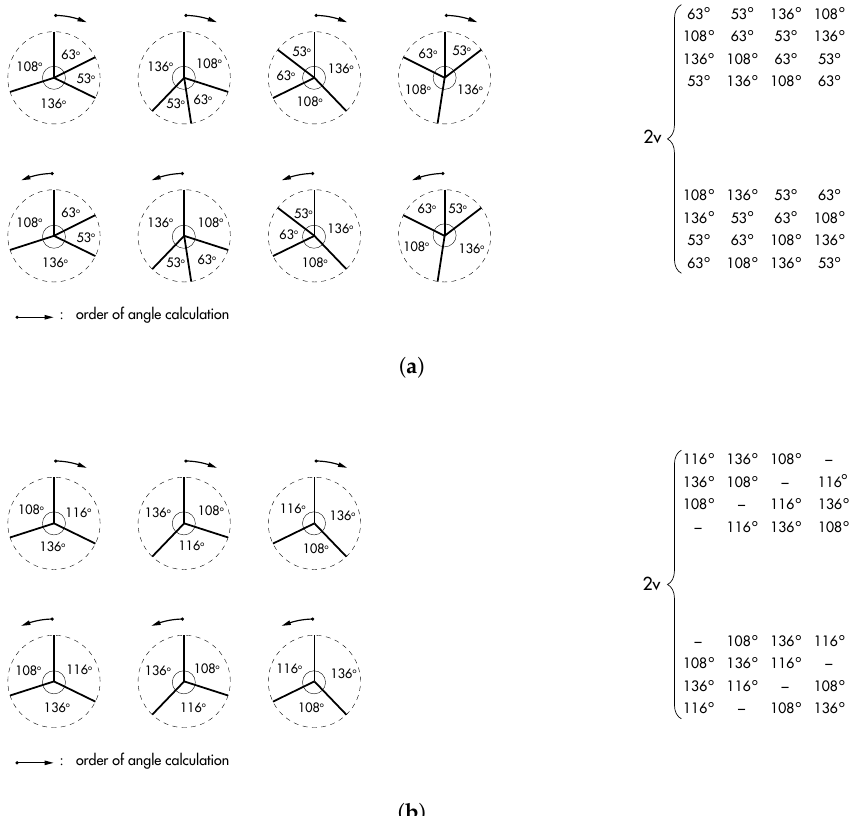
Figure 1. Every joint can be described by 2 v possible configurations of its angles, where v is the maximum valence in the structure studied. Each of these configurations are stored in a matrix A with 2 vn rows and n columns, where v is the maximum valence and n is the number of joints in the structure. In the case of joints of a smaller valence, the left over cells remain empty. ( a ) The 2 v = 8 possible angle configurations for a joint with a valence v = 4. ( b ) The 2 v = 8 possible angle configurations for a joint with a valence v = 3, when placed in a structure of a maximum valence of v =